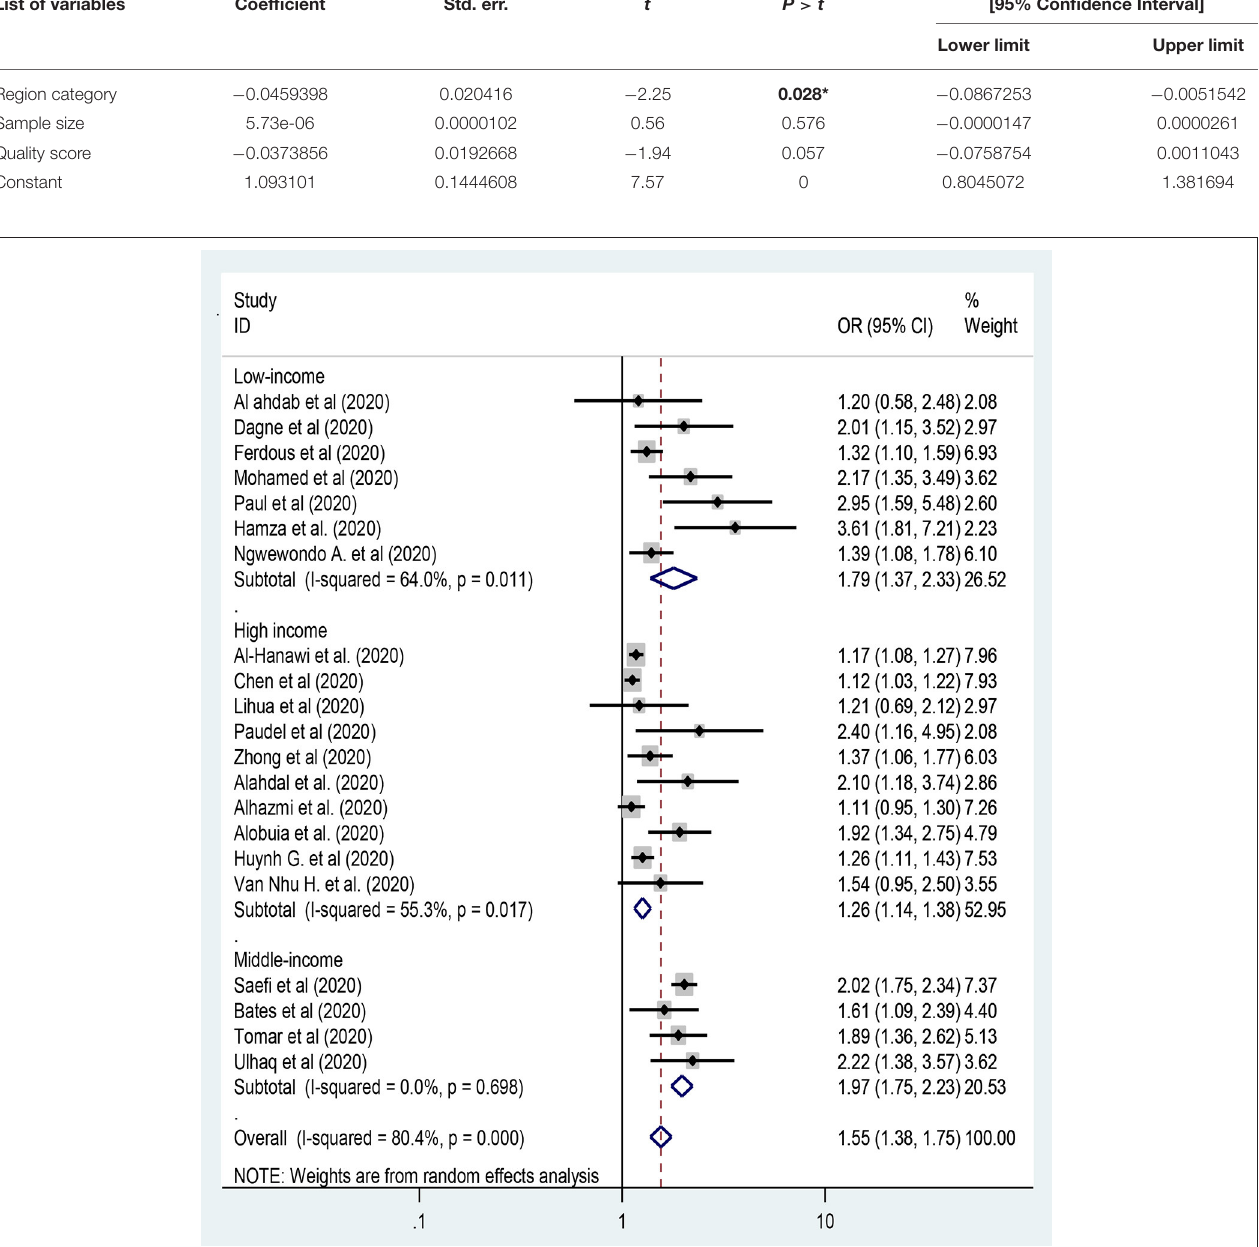
FIGURE 4 | The association between sex of the participants and level of practice toward